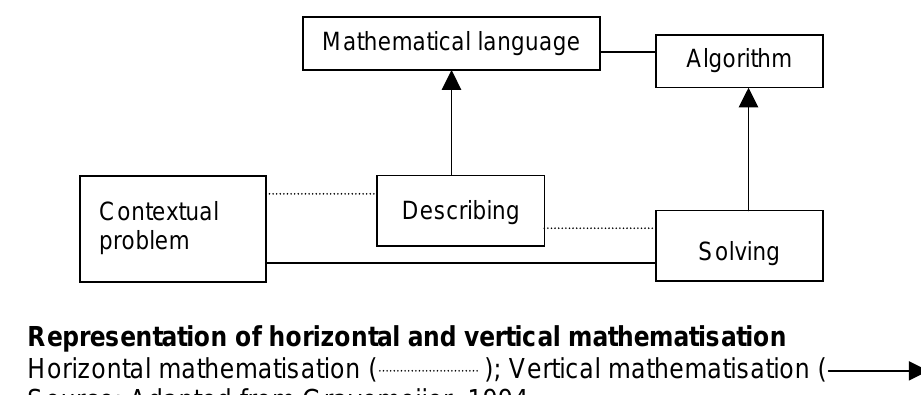
Representation of horizontal and vertical mathematisation Horizontal mathematisation ( ); Vertical mathematisation (